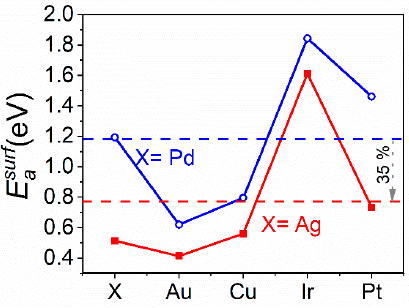
Figure 6. Activation energy barrier for surface di ff usion ( E surf a ), obtained via ab initio calculations for Ag, Au, Cu, Ir, Pd and Pt on the (111) surface in < 110 > direction of the equiatomic PtIrCuAuX (X = Ag, Pd) material system. The dashed line depicts the average activation energy barrier for the respective material systems.